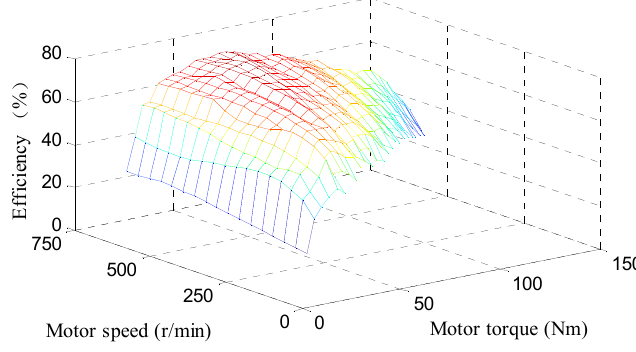
Figure 4. E ffi ciency map of an in-wheel motor. Figure 4. Efficiency map of an in-wheel motor.